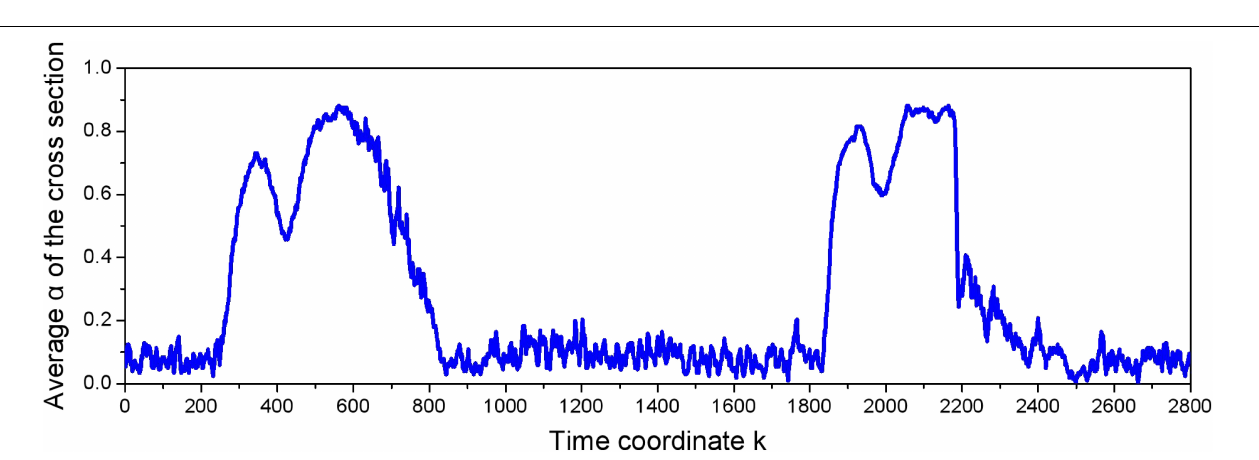
Frontiers in Energy Research |